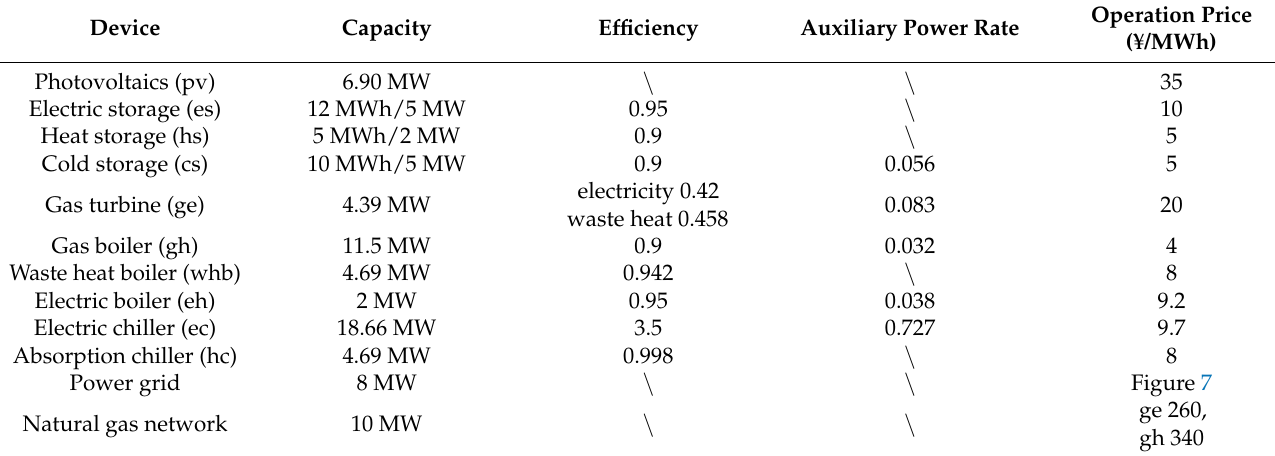
Table 2. Device parameters.